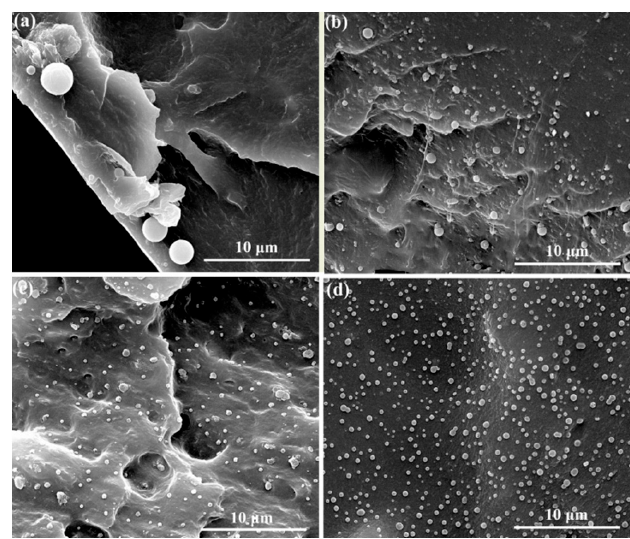
Figure 9. Polaring optical microscopy (POM) of the nanocomposites with different h-BN@(PDA+PEI) contents: ( a ) 0 wt%; ( b ) 0.5 wt%; ( c ) 1 wt%; ( d ) 2 wt% isothermal crystallization at 260 °C for 2 h, respectively.